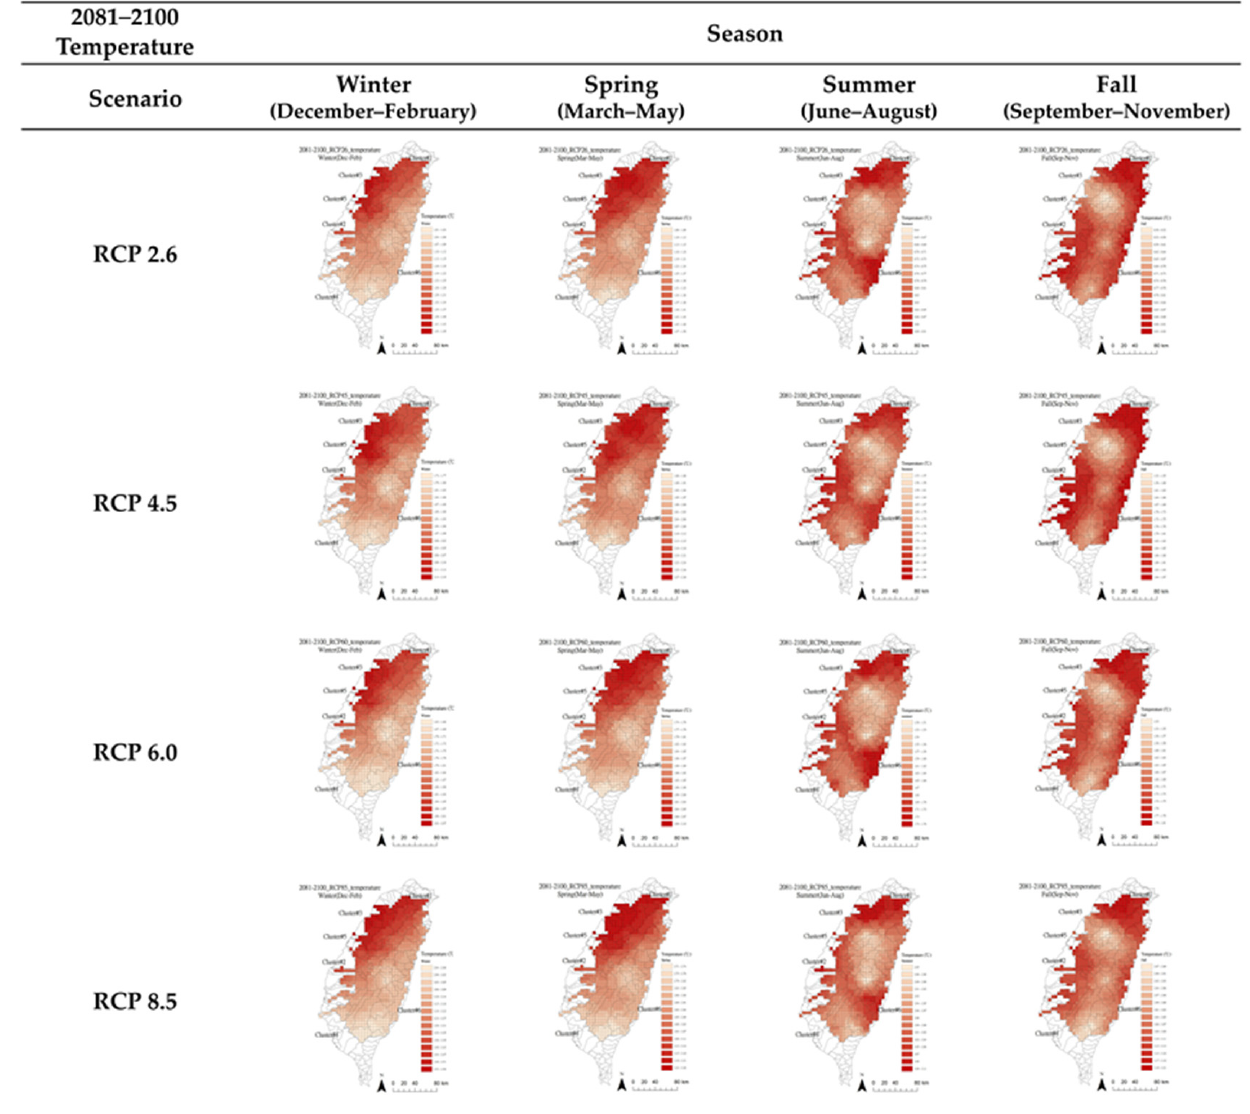
Figure A12. Spatial distribution of simulated temperature data from 2081–2100 for four seasons under different climate change scenarios.